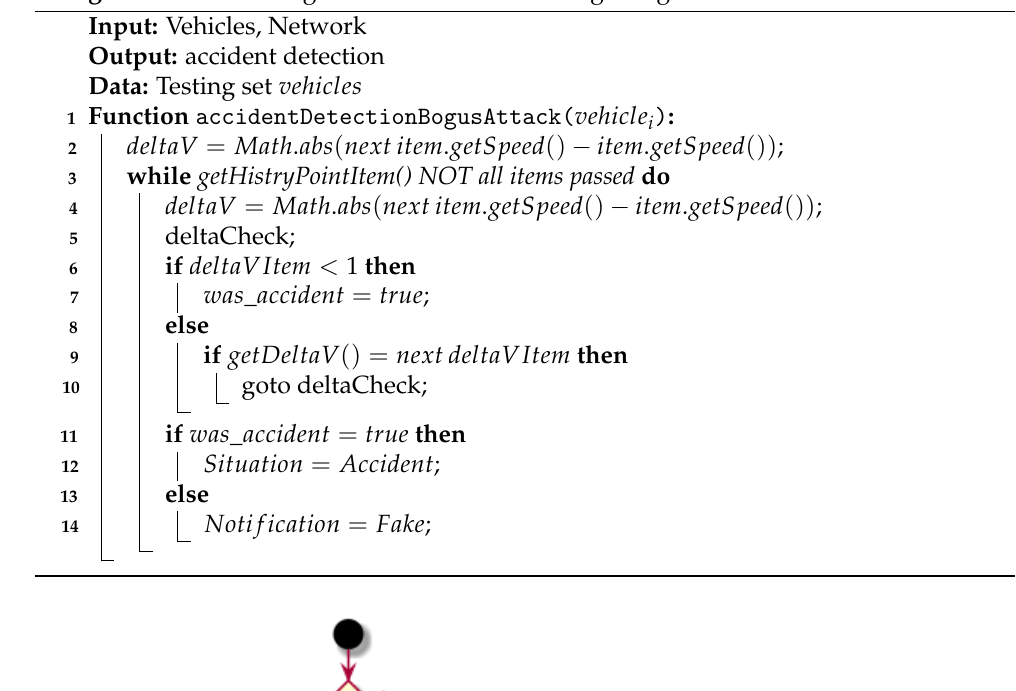
Algorithm 2: Handling accident detection during a bogus attack.